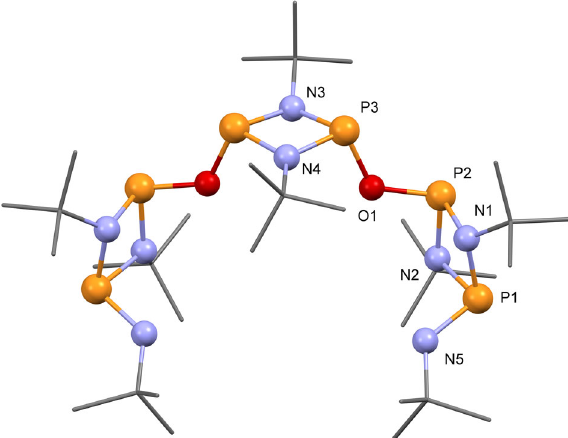
Fig. 3 Trimeric poly-cyclophosphazane (3) trapped by reaction with t BuNH 2 . Solid-state structure of 4 . The tert-butyl groups are drawn as wireframes in all the graphical representations. H atoms are omitted for clarity. For thermal ellipsoid representation, selected bond lengths, and angles see Supplementary Fig. S24.